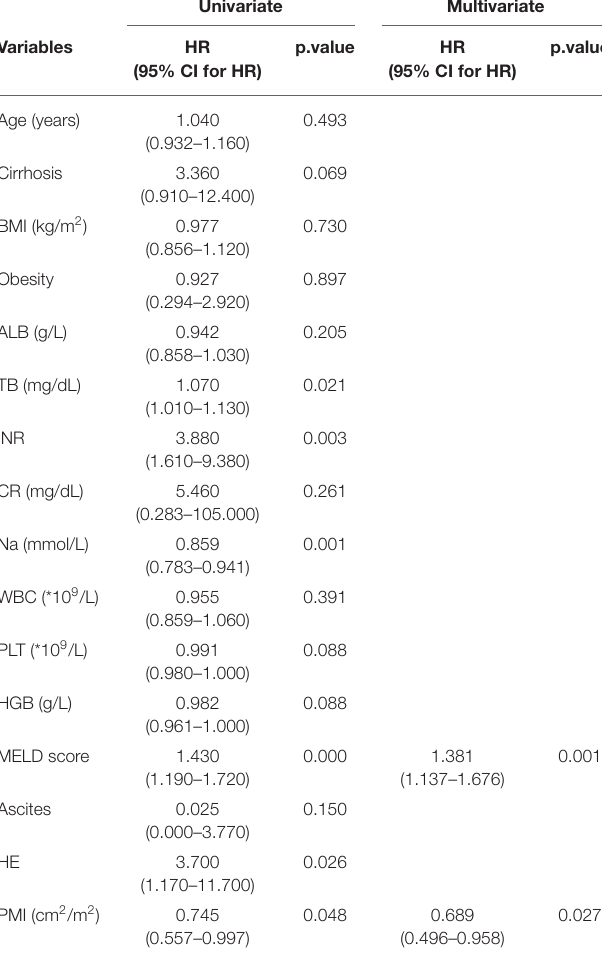
TABLE 3 | Univariate and multivariate Cox regression models in young (age ≤ 40 years) male ACLF patients. Univariate Multivariate